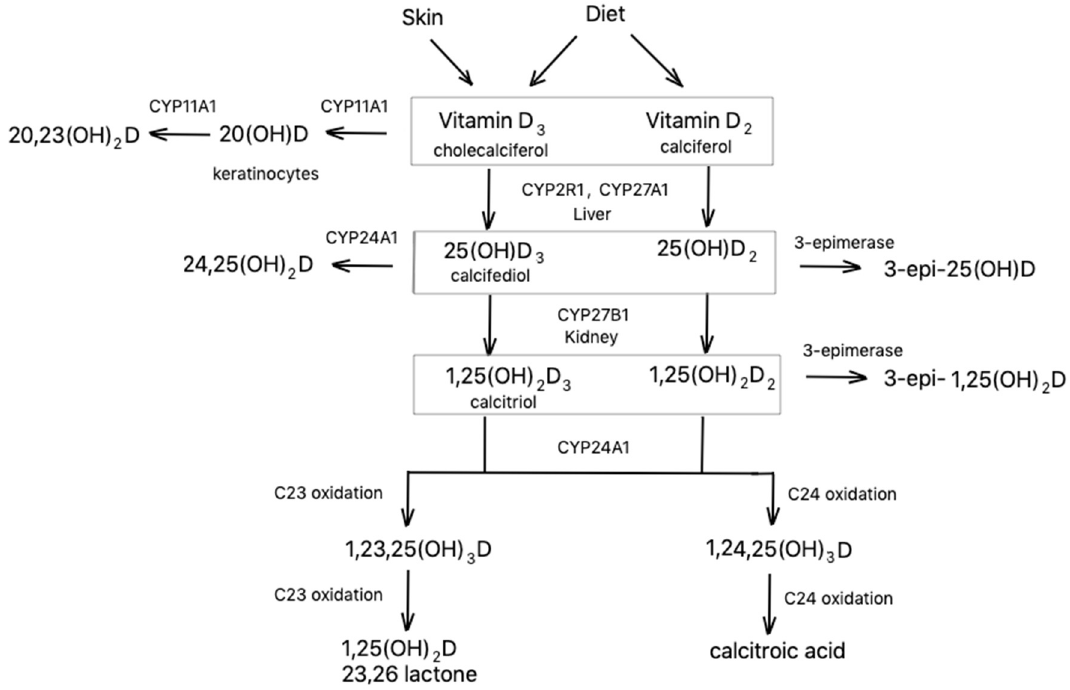
Figure 1. Metabolism of vitamin D.